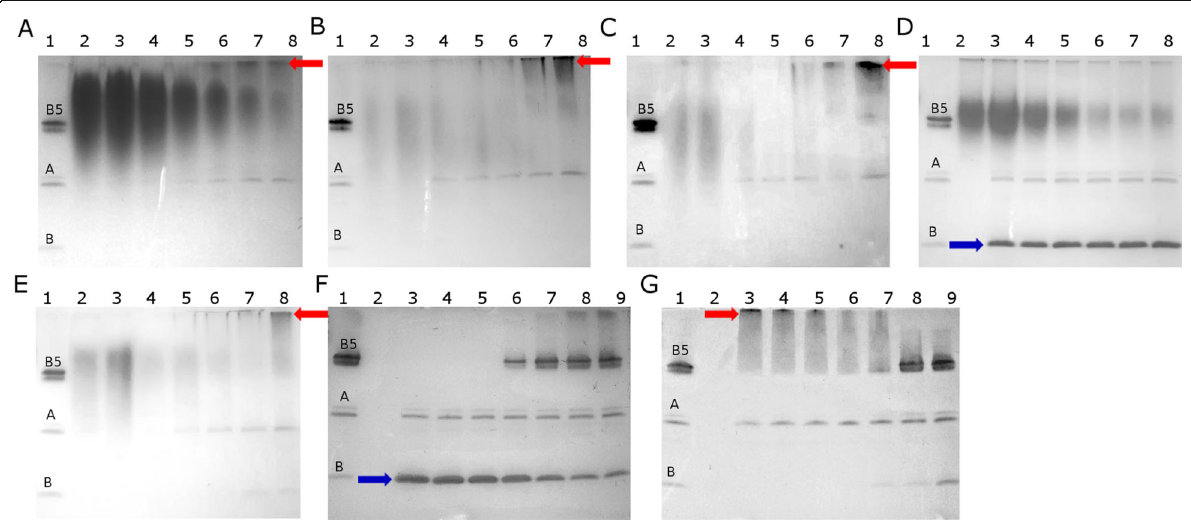
Fig. 7 SDS PAGE analysis of the interaction between cholera toxin and plant extracts. a agrimony, b blackberry leaf, c raspberry leaf, d rosehip, e wild strawberry leaf, f gallic acid control and g GM 1 control. For all panels, lane 1 contains 2 μ g CTX (dissociated into: B 5 – 57 kDa, A – 28 kDa and monomer B – 11.4 kDa), lane 2 – 1 mg of plant extracts or 0.1 mg gallic acid or 2 μ g GM 1 . For panels (A-E), lanes 3 – 8 contain 2 μ g CTX and: 1.0, 0.5, 0.25, 0.125, 0.06, 0.03 or 0.0015 mg plant extract. For panel F, lanes 3 – 8 contain 2 μ g CTX and: 0.1, 0.05, 0.025, 0.0125, 0.006, 0.003 or 0.0015 mg gallic acid. For panel G, lanes 3 – 8 contain 2 μ g CTX and: 2.0, 1.0, 0.5, 0.25, 0.125, 0.06, 0.03 μ g GM 1 . The red arrow indicates aggregated protein, the blue arrow shows increased amount of monomer B. The reaction volume was 12 μ l for all